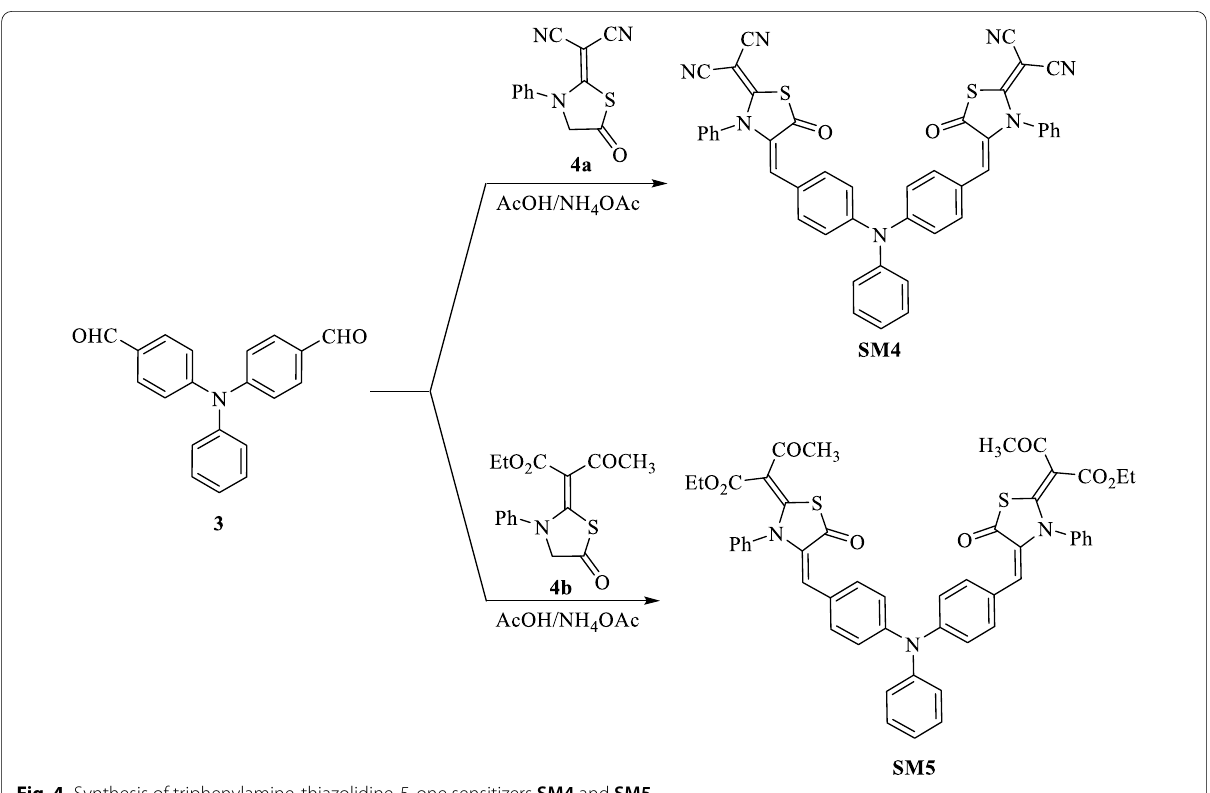
Fig. 4 Synthesis of triphenylamine‑thiazolidine‑5‑one sensitizers SM4 and